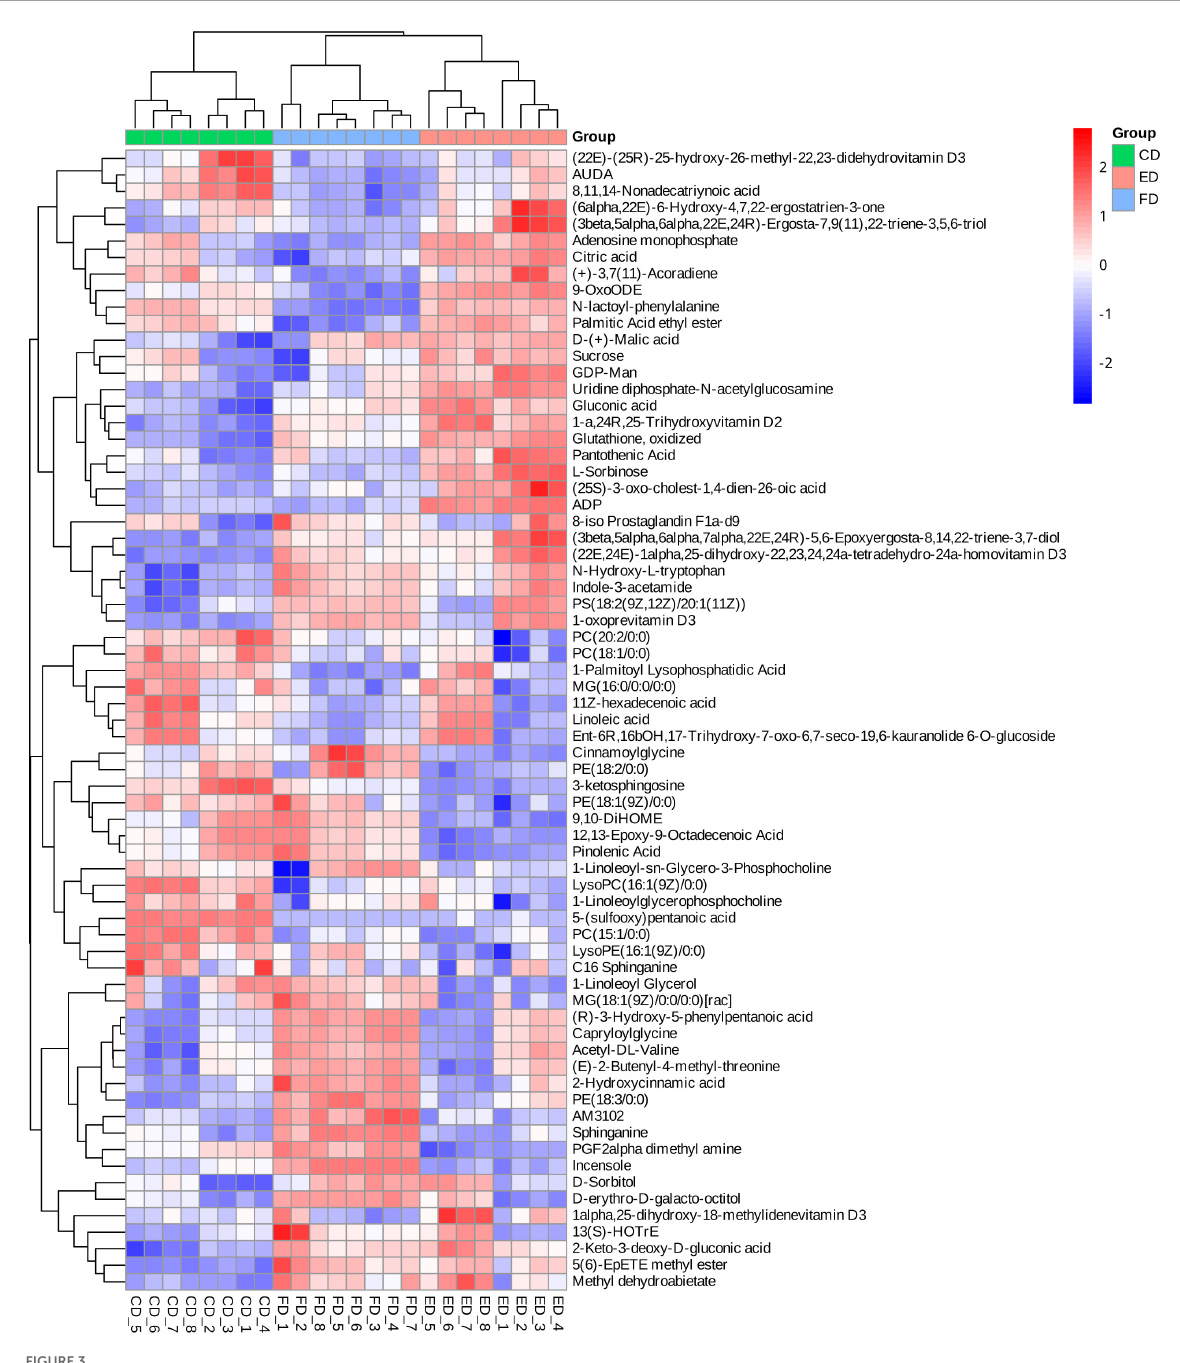
their derivatives were screened in D. rubrovolvata, including two nucleotides and two nucleotide sugars. The relative levels of the four nucleotides showed certain